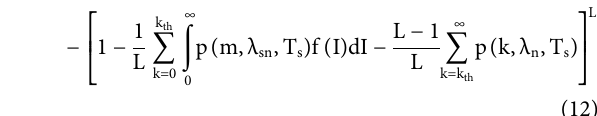
TABLE 3 | Parameters of UPCC system.